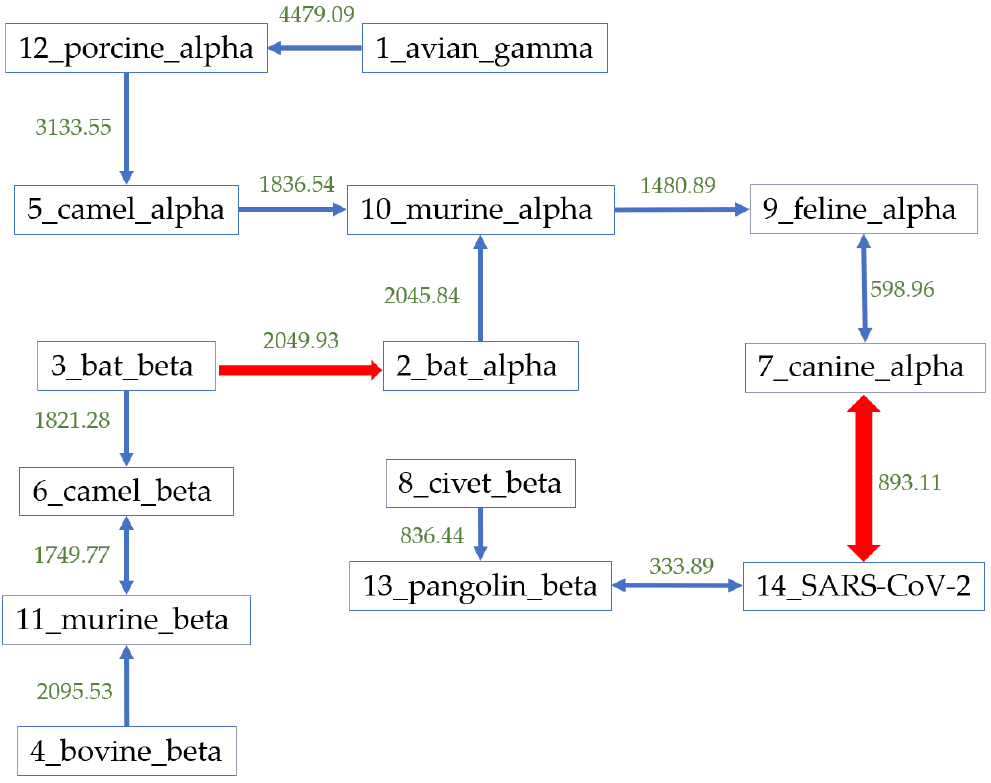
Figure 6. The natural graph of 13 possible host sources and SARS-CoV-2 group. The blue arrows represent the first-level relationship while the red ones represent the second-level relationships. First level indicates closer